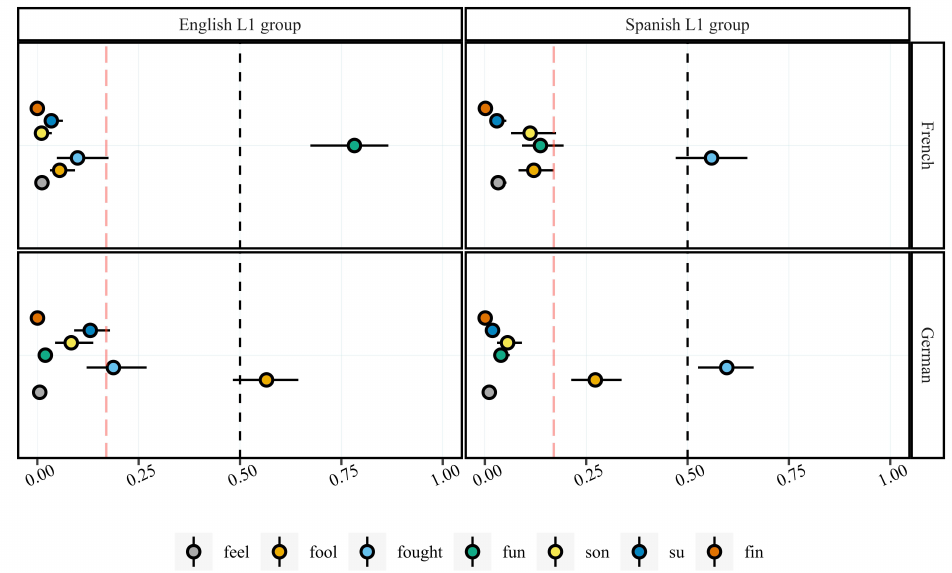
Figure 11. The probability of each answer choice given the phoneme